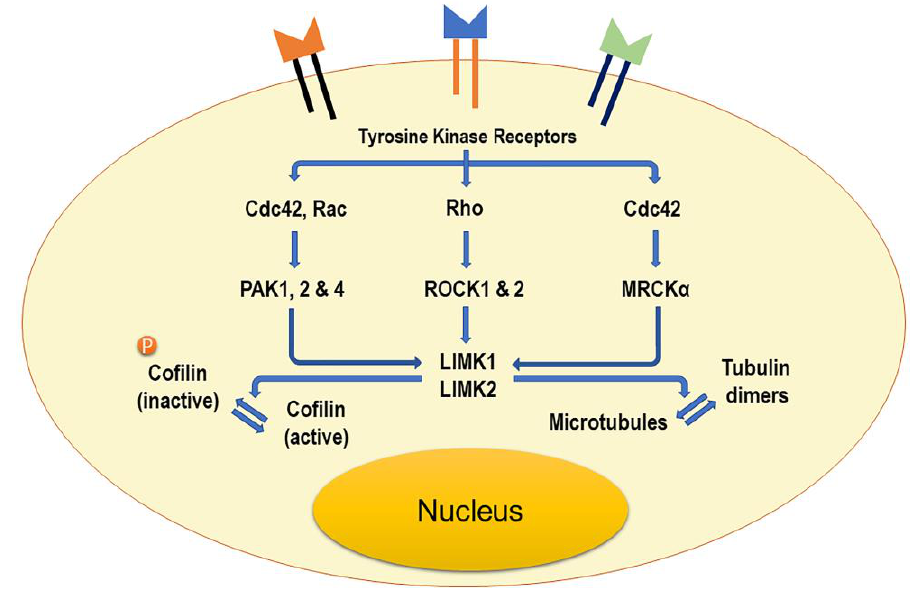
Figure 2. A model for LIMK1 and LIMK2 signaling pathways in normal cells. Several molecules are complicatedly linked and control LIMK activity.